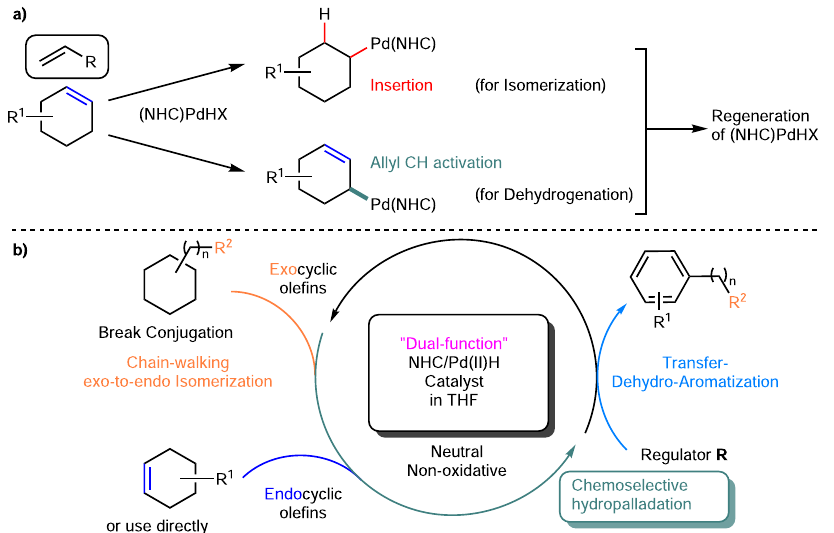
Fig. 3 | Catalytic action of (NHC)Pd(II)H. a Cooperative steric effects of NHC and the alkene enable interchangeability of the Pd(II)H reactivity. b Conversion of